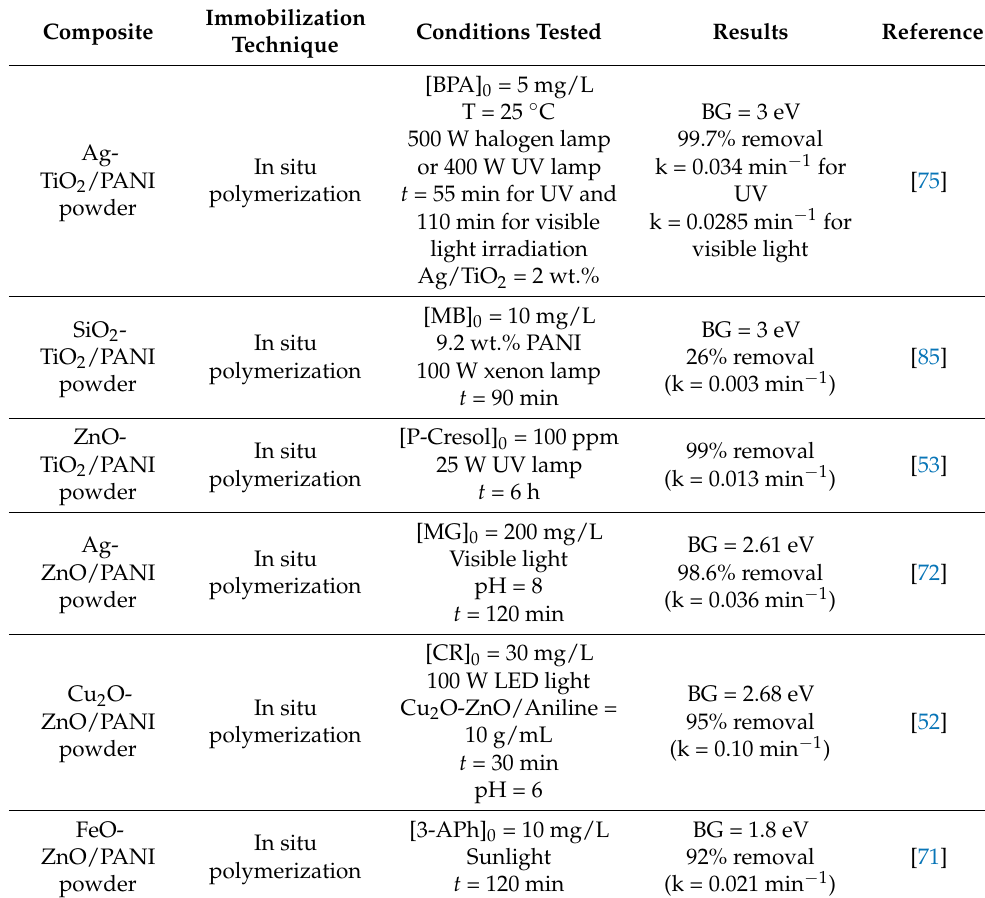
Table 9. Summary of studies that have analyzed the effect of modifying the catalyst surface on the PANI-supported photocatalysis